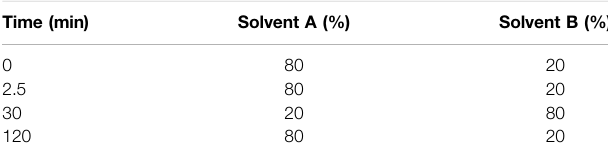
TABLE 2 | | Gradient of the mobile phase used for elution of galangin in the ethanolic leaf extract of Greyia radlkoferi . Time (min)